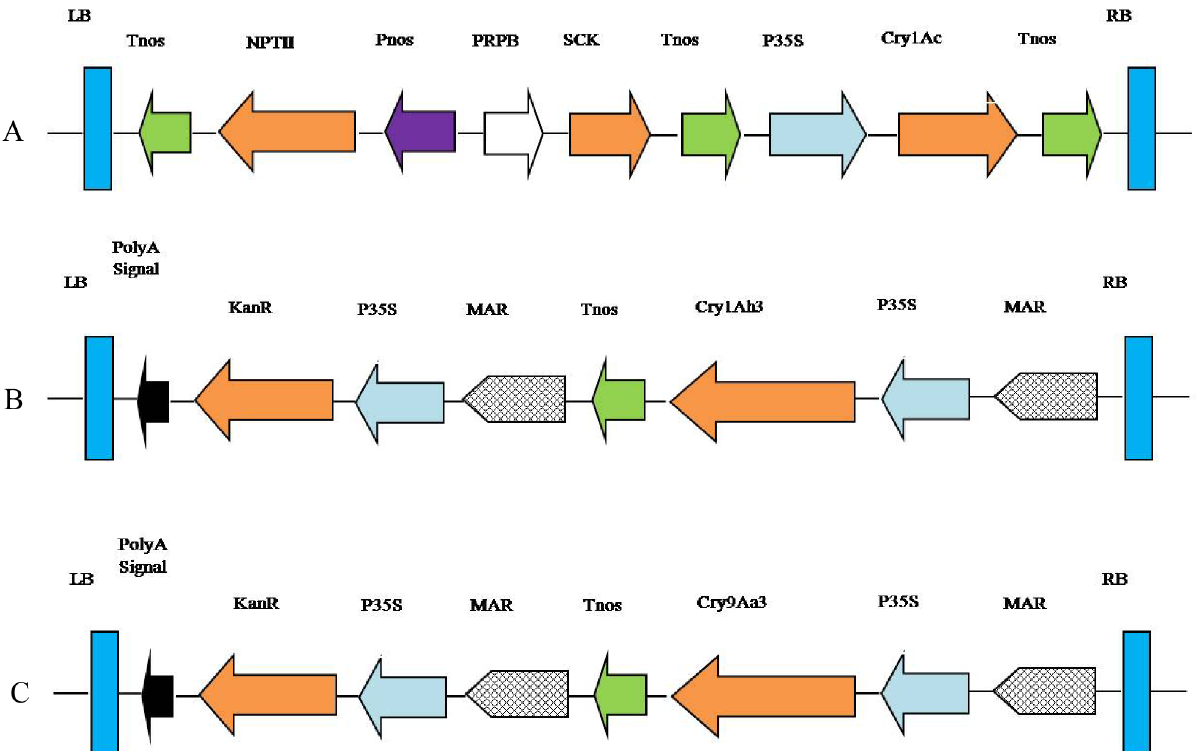
Fig 1. Frame diagrams of plant transformation vectors. (A) pCRPBSCK35SBt.(B) pP1Ah3. (C) pP9Aa3.LB: Left border; RB: right border; P35S: the cauliflowermosaic virus (CaMV) 35S promoter; NPT II or KanR: neomycinphosphotransferase II gene; Tnos or Poly A signal:poly-adenylation site of the nopalinsynthase gene; MAR: matrix attachment region; Pnos: promoter of the nopalinsynthase gene; PRPB: promoter of replicationprotein of CLCuV (Cotton leaf curl virus).